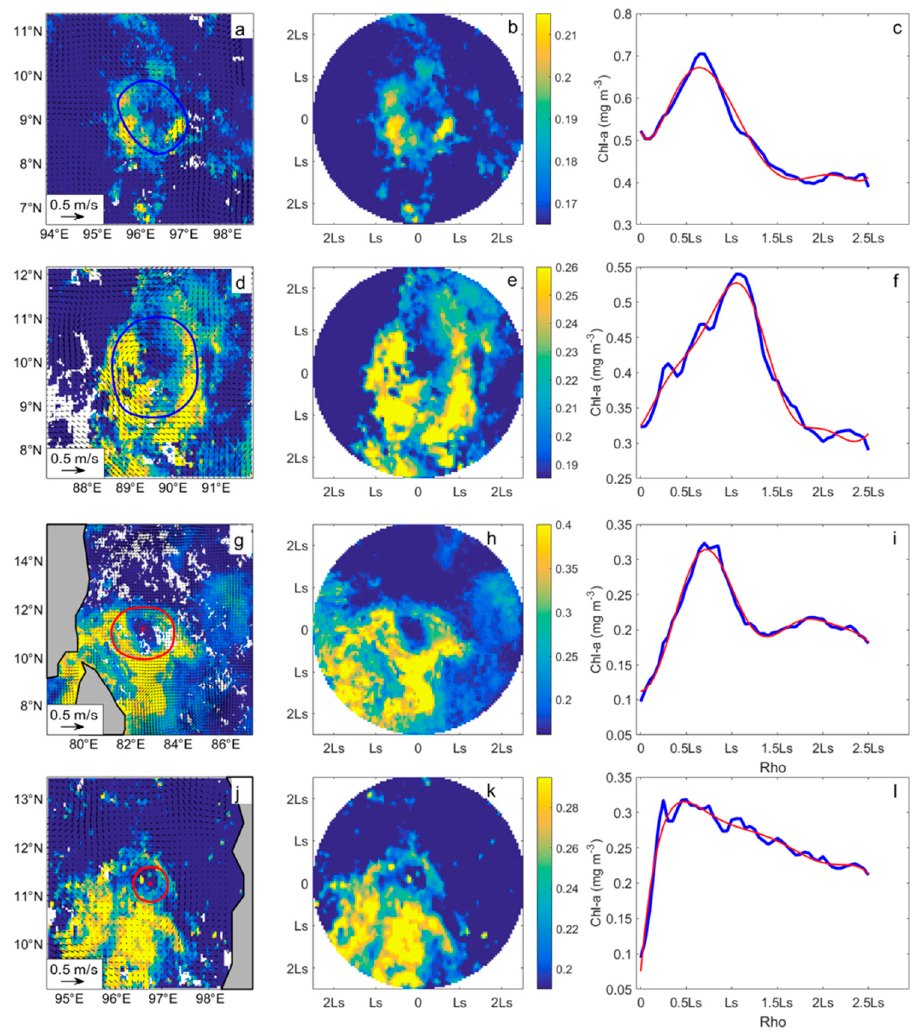
Figure 21. Schematic diagram of Chl rings. CE is represented by ( a–f ), and AE is represented by ( g–l ). ( a ) An CE matched with Chl concentration data. Vectors represent geostrophic velocities. ( b ) Chlorophyll region is transformed into polar coordinates. ( c ) Distribution of the averaged chlorophyll as a function of the eddy radius. The peak of averaged Chl concentration locates around Ls, which denotes the eddy radius. Rho refers to the normalized distance from the eddy center related to Ls. Among them, blue is Chl data, and red is Fourier fitting curve. ( d–f ), ( g–i ), ( j–l ) have the same meaning as ( a–c ).